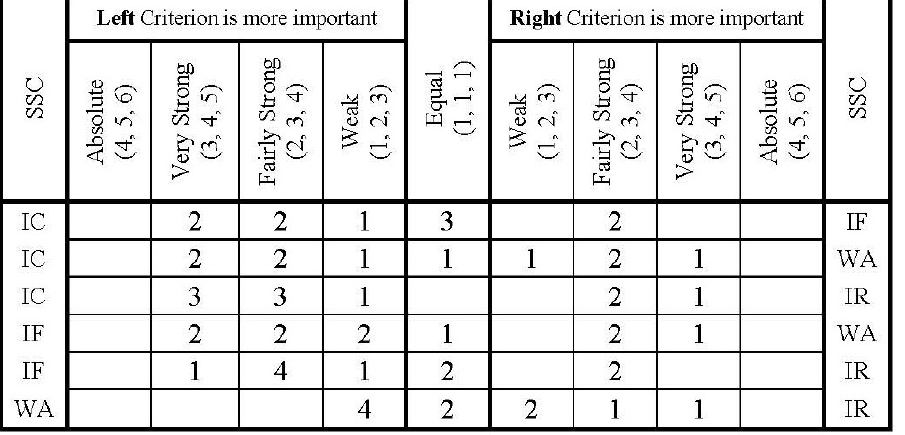
Figure 3. Survey questionnaire for weighting SSCs.